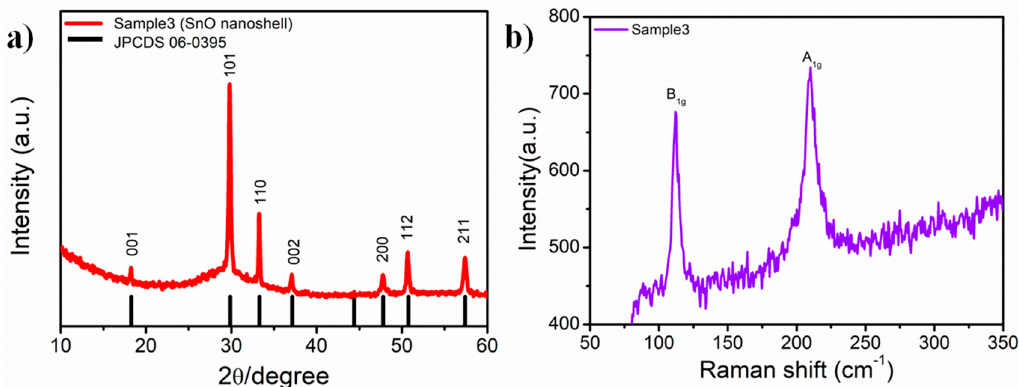
Figure 2. Characterization of the crystal structure of Sample 3. ( a ) X-ray diffraction of Sample 3; ( b ) Raman spectrum of Sample 3.